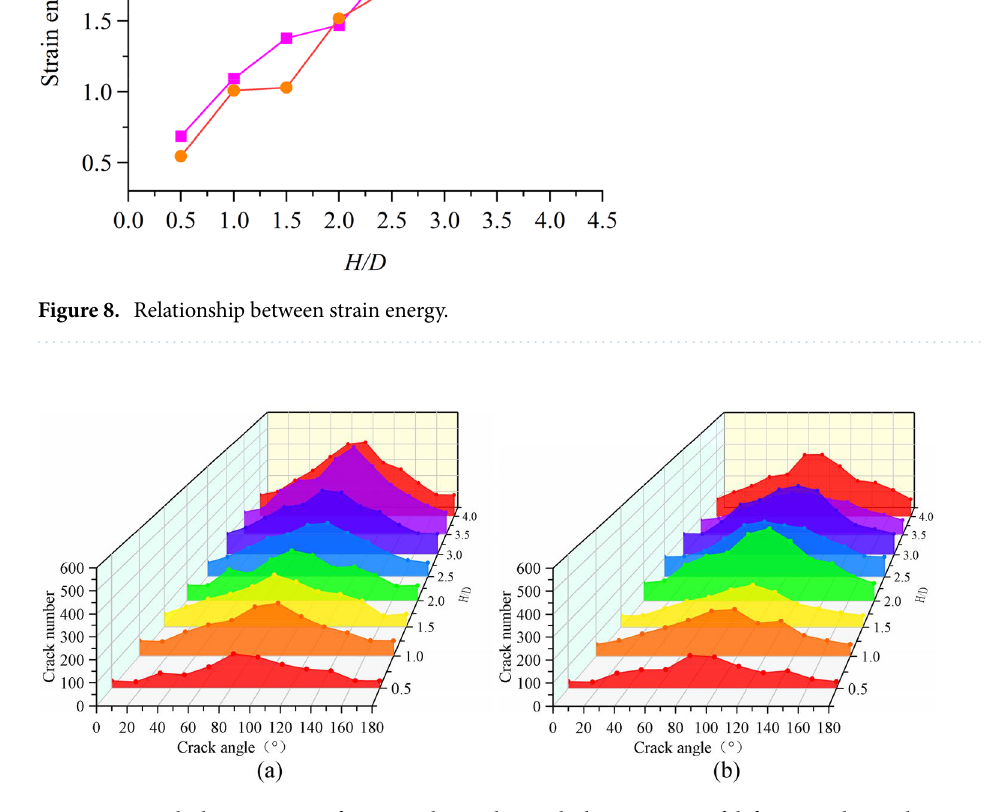
Figure 9. Crack characteristics of intact rock samples crack characteristics of defective rock